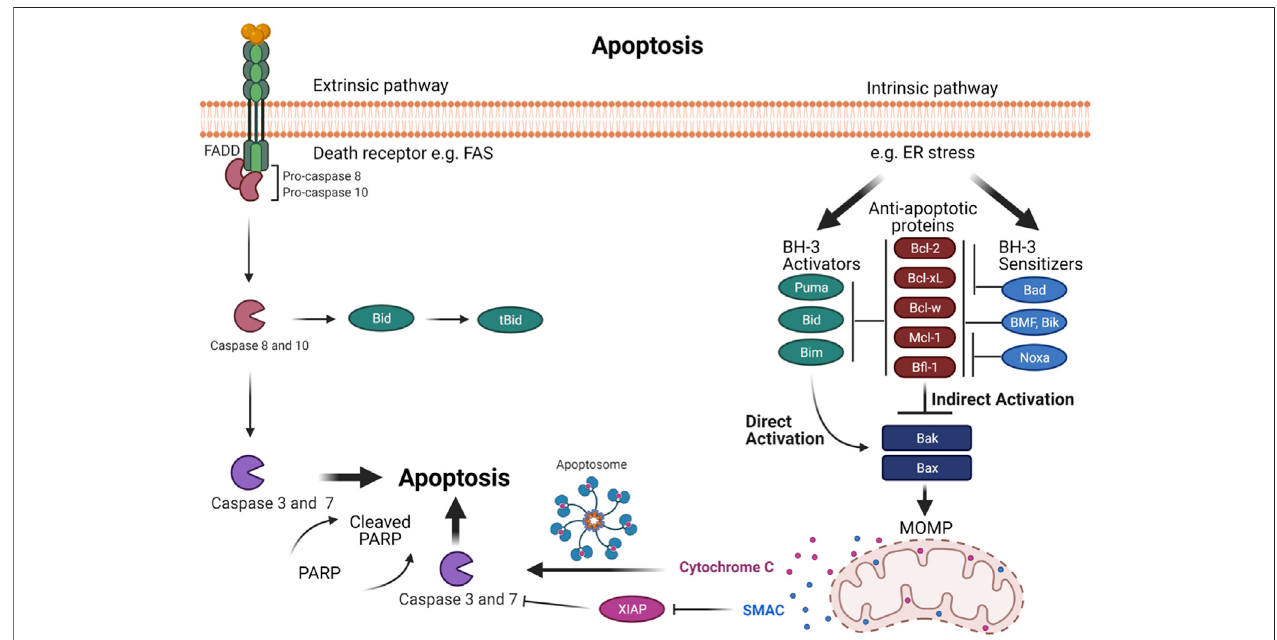
FIGURE2 | Theprogrammed cell death- via intrinsic and extrinsicpathwaysin normal mammalian cells. Intrinsic and extrinsicpathwaysresult in the activation ofa family of protease enzymes called Caspase proteins. The intrinsic pathway is promoted by cellular stresses that modulate Bcl-2 family proteins and activates Bak and Bax. In theindirect activation, upregulation ofBH3-only proteins will act asinhibitorsofanti-apoptotic proteins bycompeting fortheir binding withBax and Bak proteins, leading Bax and Bak to oligomerize. In the direct activation, upregulation of BH3 activators proteins directly activates Bax and Bak. This activation leads to mitochondrial outer membrane permeabilization (MOMP), subsequently Cytochrome C and SMAC proteins release into the cytosol, causing the downstream of Caspase activation that ends with apoptosis. The extrinsic pathway is promoted by death receptors activation. This leads to activation of initiator Caspases 8 and 10, which can regulate the downstream executioner Caspase such as Caspase 3 and 7 to drive full commitment to apoptosis. Moreover, Caspases 8 and 10 can activate Bid, which in turn activates Bak and Bax to induce MOMP which establishes the link between the extrinsic and intrinsic